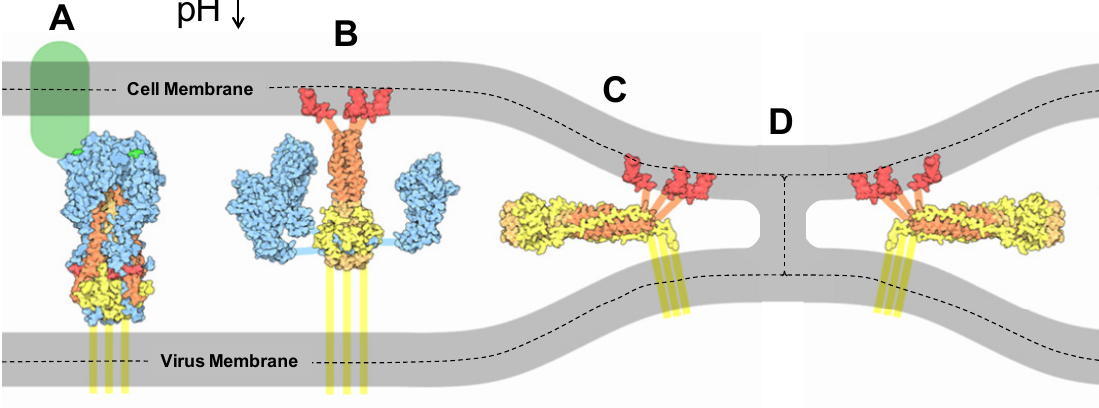
Figure 3. HA-mediated membrane binding and fusion between the viral and endosomal membranes. ( A ) HA (blue) binding to a moiety containing sialic acid group on the plasma 1 membrane (light green); ( B ) After a reduction in pH in the endosome, HA conformational change that drives the fusion peptides (red) into the host cell membrane; ( C ) A further conformational change brings the outermost leaflets of the opposing membranes together to form a stalk ( D ), where it is thought to be the action of several fusogenic HA working in concert. The dashed lines divide the upper and lower leaflets of 2 the membranes for clarity. (Figure adapted from the Protein Data Bank [89]). Eventually the stalk collapses to form a pore (not